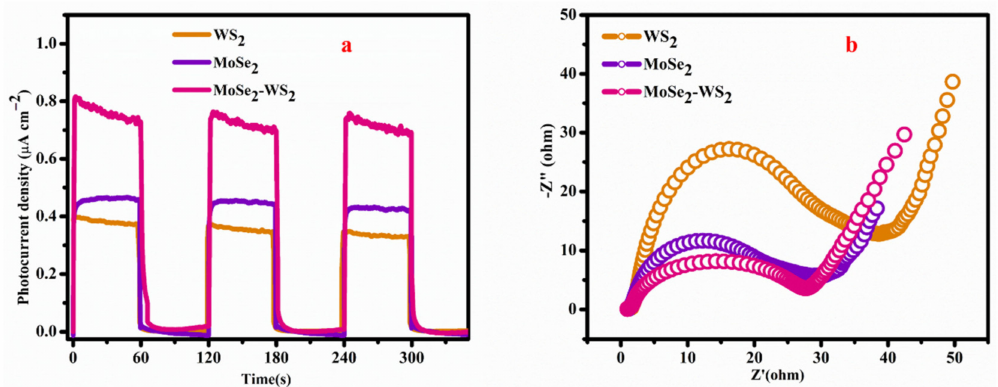
Figure 8. ( a ) Photocurrent response and ( b ) EIS spectra of WS 2 , MoSe 2 and MoSe 2 -WS 2 nanostructure. Identically, the photocurrent response of MoSe 2 -WS 2 is higher than that of bare WS 2